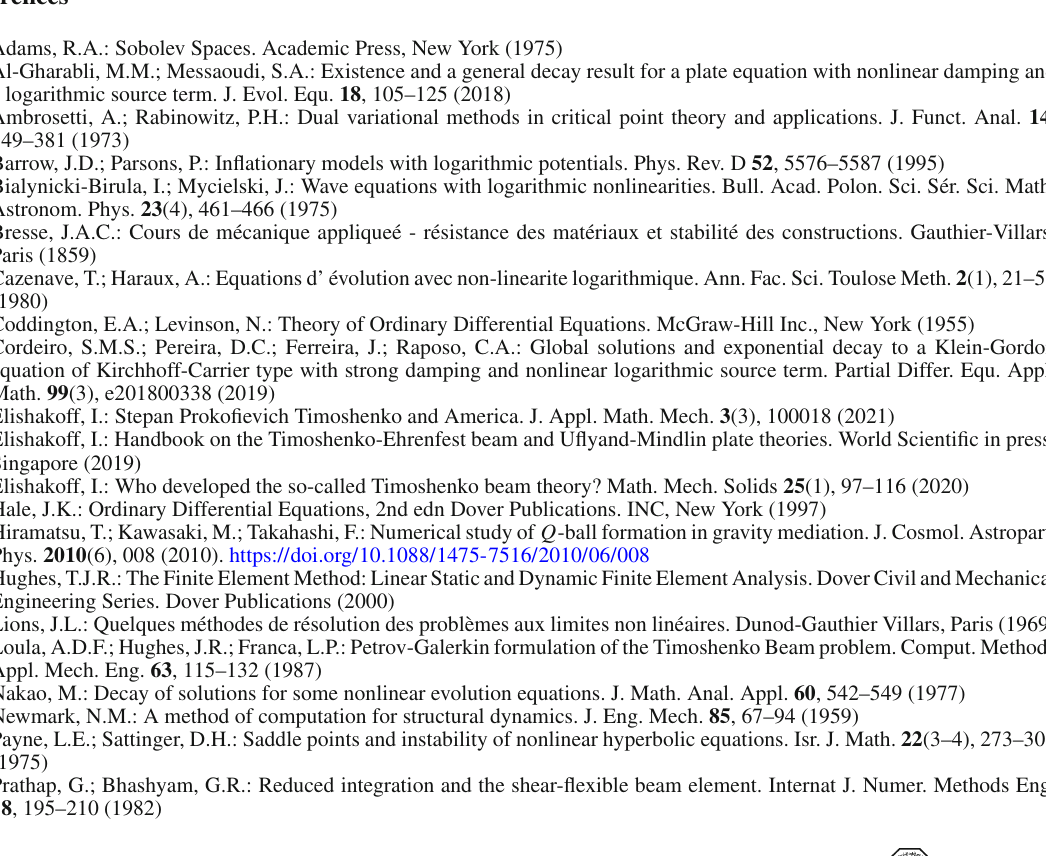
= 1 . 0 , μ = 1 . 0. and the following 1 2